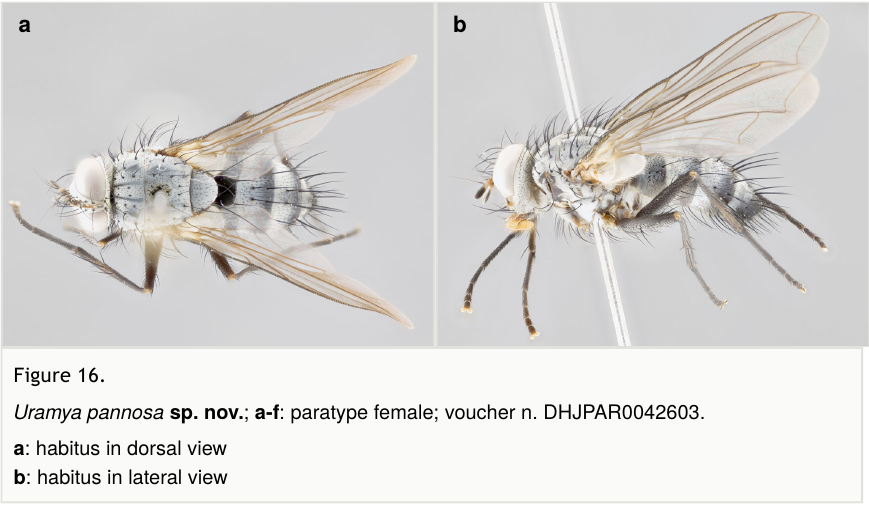
Uramya pannosa sp. nov. ; a-f : paratype female; voucher n.